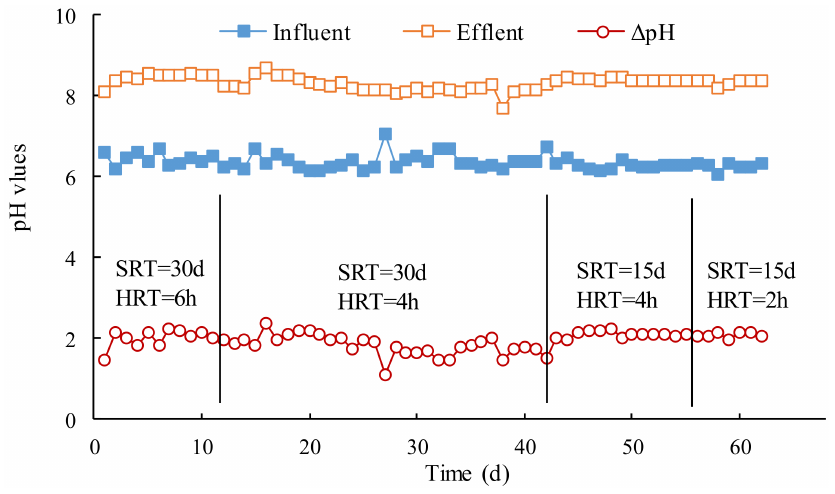
Figure 3. Effect of SRT and HRT on variation of pH